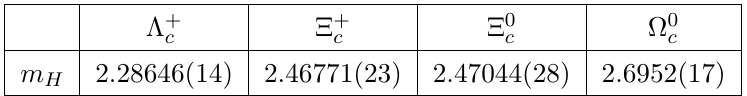
Table 17. Masses of singly charmed baryons, in GeV, taken from PDG [21]. Uncertainties in the final digit(s) are neglected in this study, but are given in